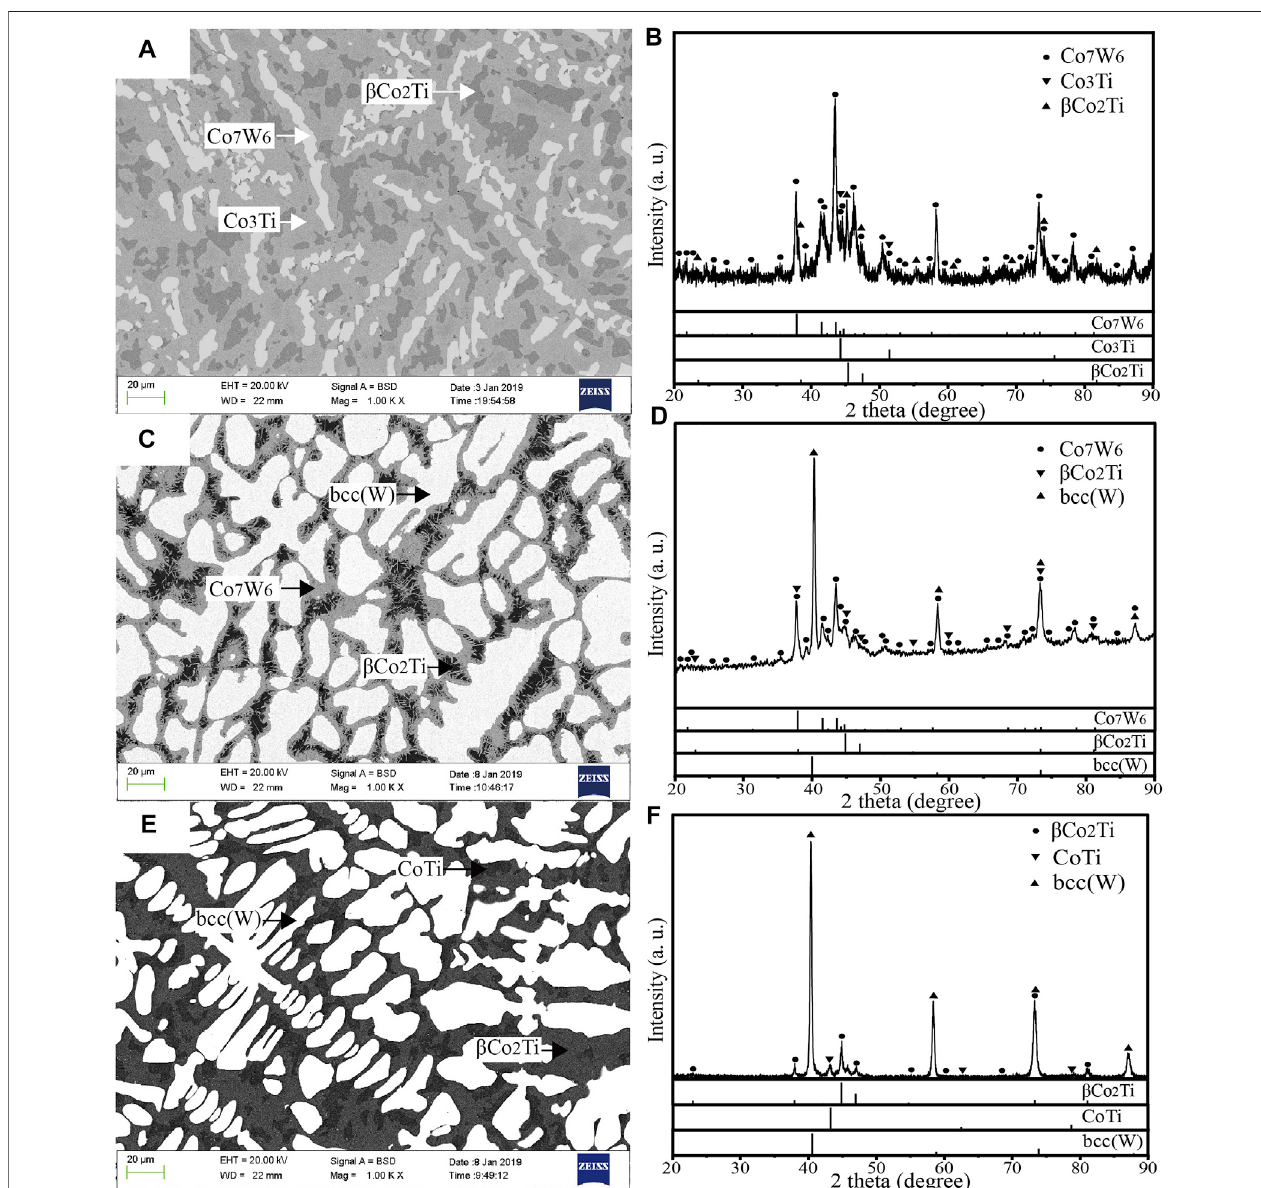
FIGURE 4 | BSE micrographs and XRD patterns of alloys (A) and (B) for a7 (C) and (D) for a8 (E) and (F) for a9.